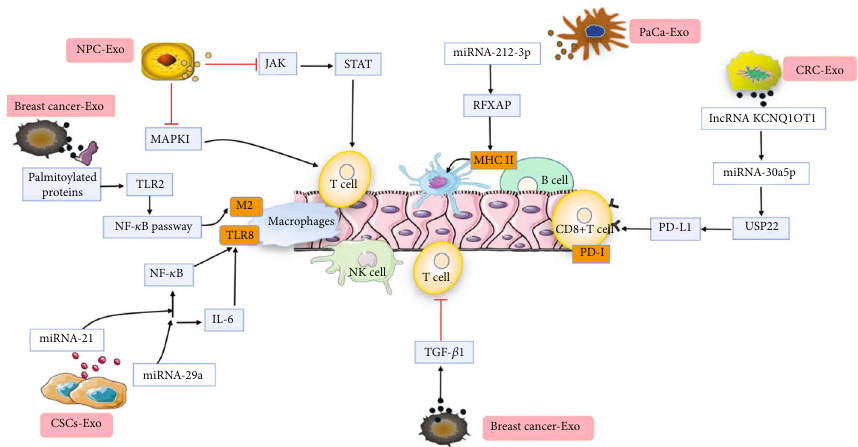
Figure 4: CSC-Exos regulate cancer cells to evade immune surveillance. MiRNAs contained in nasopharyngeal carcinoma (NPC) cell- derived exosomes downregulate the MAPKI and JAK/STAT pathways to impair T-cell proliferation, di ff erentiation, and cytokine secretion. miRNA-21 and miRNA-29a can bind to Toll-like receptor 8 (TLR8) on the surface of tumor-associated macrophages through the action of CSC-Exos, triggering the NF- κ B pathway and the secretion of interleukin-6 (IL-6) to induce evasion of immune surveillance. Exosomes derived from pancreatic cancer (PaCa) cells contain miR-212-3p, which inhibits the expression of regulatory factor X-associated protein (RFXAP), resulting in a decrease in the expression of MHC II molecules (molecules on the surface of B cells) and induction of immune tolerance. Breast cancer-derived exosomes inhibit the proliferation of T cells through TGF- β 1, interfering with normal immune system function. The lncRNA KCNQ1OT1 loaded in colorectal cancer cell-derived exosomes (CRC-Exos) mediates the miR-30a-5p/USP22 pathway to regulate the ubiquitination of PD-L1 and inhibits the CD8+ T-cell response, thereby promoting colorectal cancer cell evasion of immune surveillance. Macrophage immunomodulation by breast cancer cell-derived exosomes requires Toll-like receptor 2-mediated activation of the NF- κ B pathway, which induces pro-in fl ammatory activity of distant macrophages in cancer